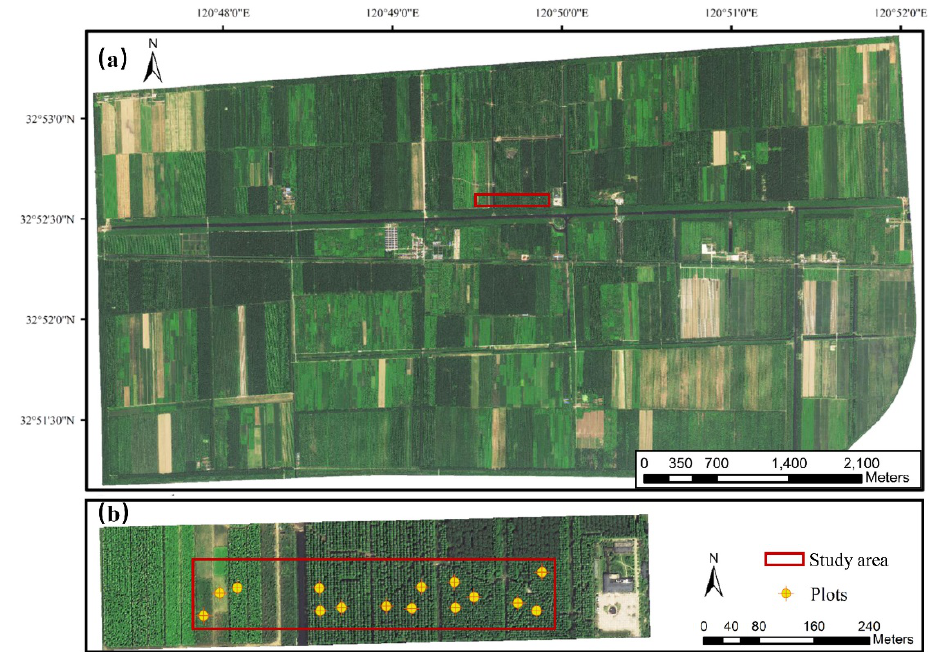
Figure 1. The location of study area in Dongtai forest farm, and 15 sample plots. High-resolution orthophoto was generated using digital aerial imagery acquired from an unmanned aerial vehicle (UAV), covering the whole study area. ( a ) Location and orthophoto of Dongtai forest farm; ( b ) Orthophoto of the study area, and locations of the sample plots.